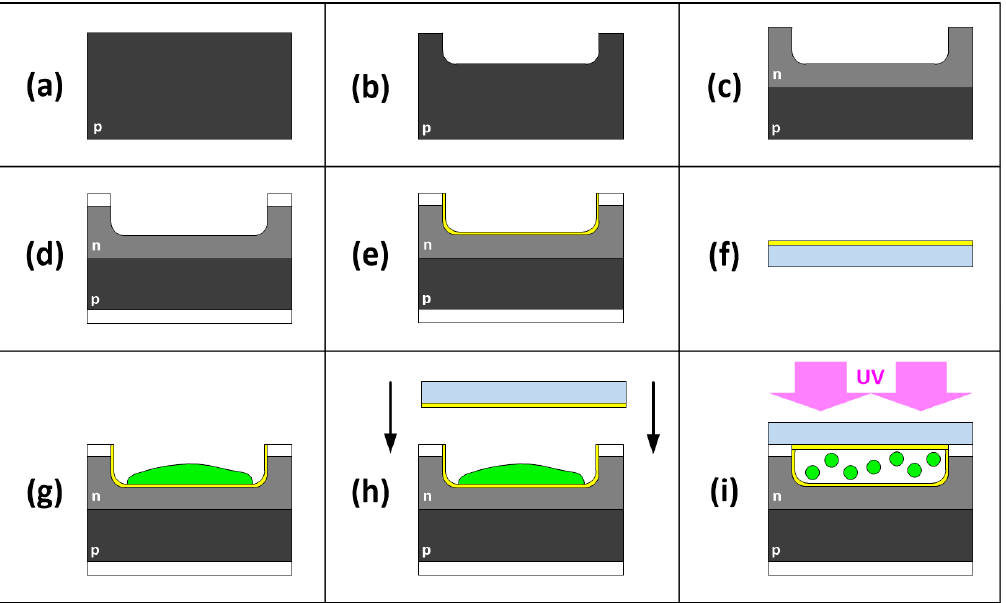
Figure 2. Fabrication process overview: ( a ) Si wafer (p-type) of 300 µm thickness as substrate; ( b ) RIE etching of 180 µm-wide through holes in area 1 mm 2 ; ( c ) ionic implantation type n for fabrication of the photodiode; ( d ) aluminum contacts (cathode and anode) for photodiode; ( e,f ) PEALD 39 nm Al 2 O 3 thin fi lm deposition for di ff usion barrier; ( g ) aqueous RbN 3 solution insertion; ( h ) anodic bonding of 200 µm thick Boro fl oatR_33 window wafer; ( i ) aqueous RbN 3 solution exposition to UV light.